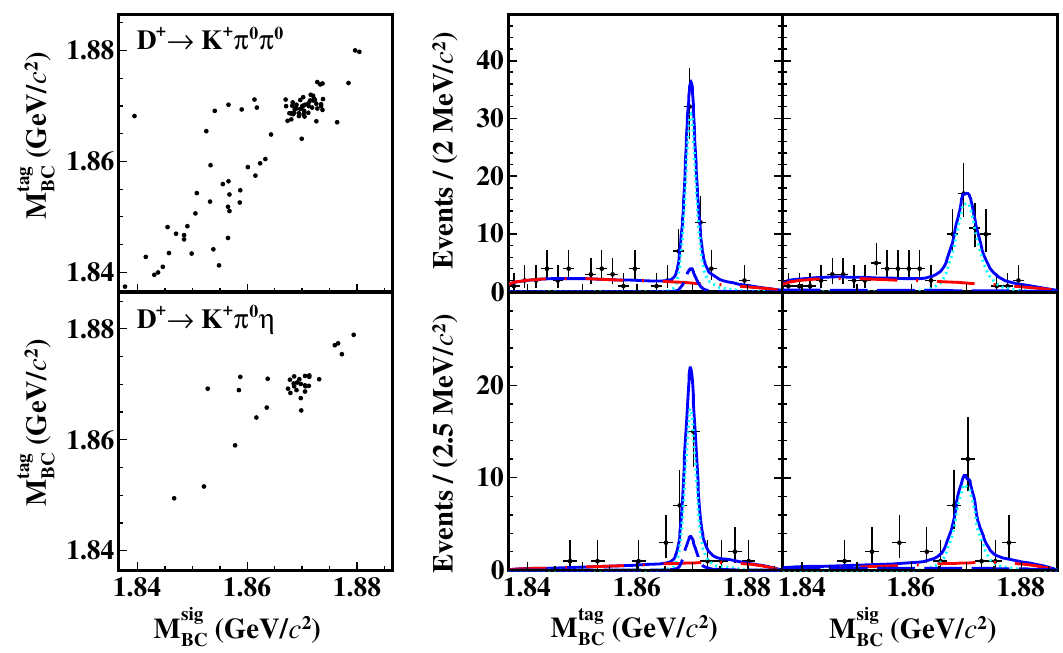
versus M sig and the projections on (middle column) Figure 1 . Distributions of (left column) M tag BC BC and (right column) M sig of the 2D fits to the DT candidate events. The top row is for M tag BC BC D + → K + π 0 π 0 and the bottom row is for D + → K + π 0 η . Points with error bars are data. Blue solid curves are the fit results. Cyan dotted curves are the fitted signal distributions. Blue long- dashed curves are BKGI. Red dot-long-dashed curves are